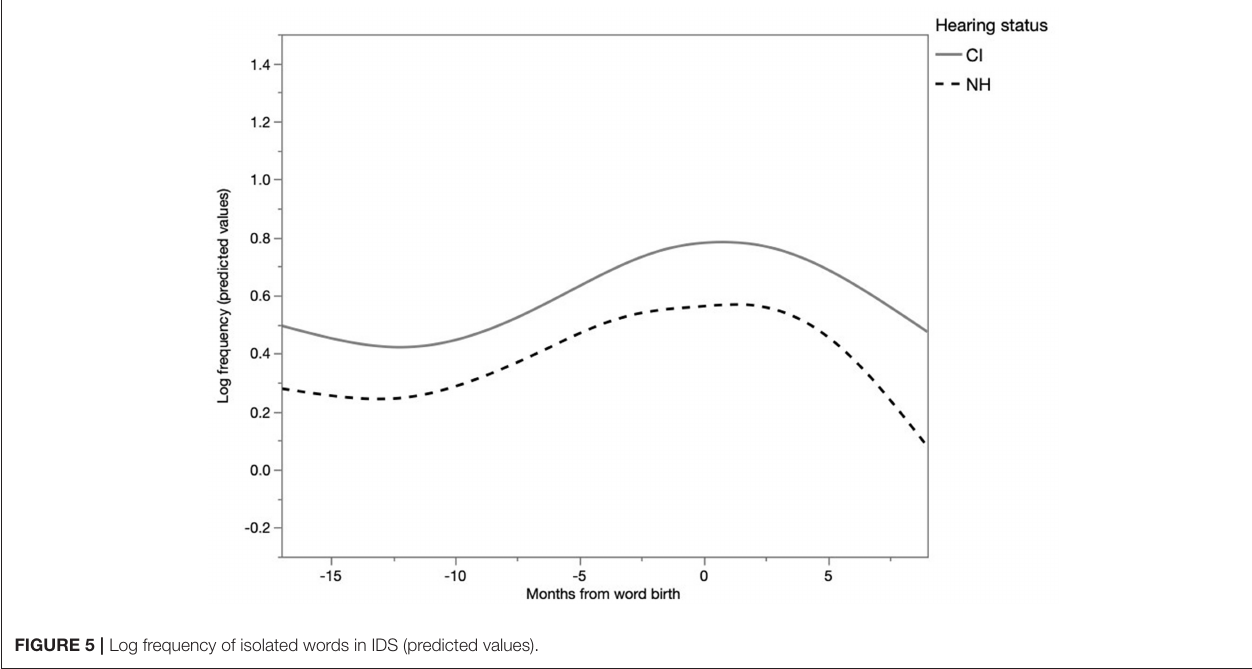
FIGURE 5 | Log frequency of isolated words in IDS (predicted values).